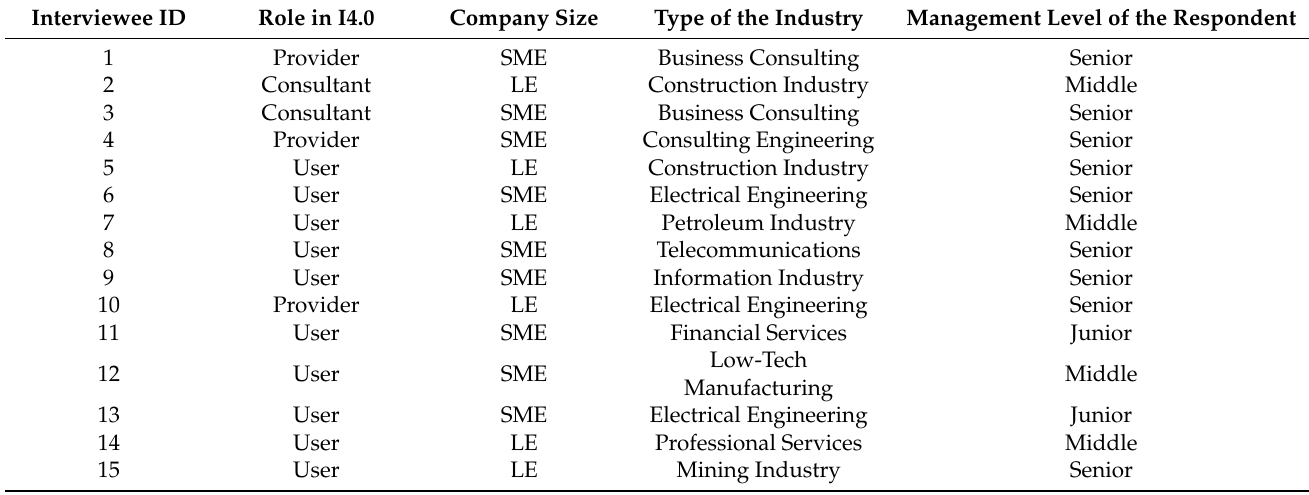
Table 2. Participants details of the experts’